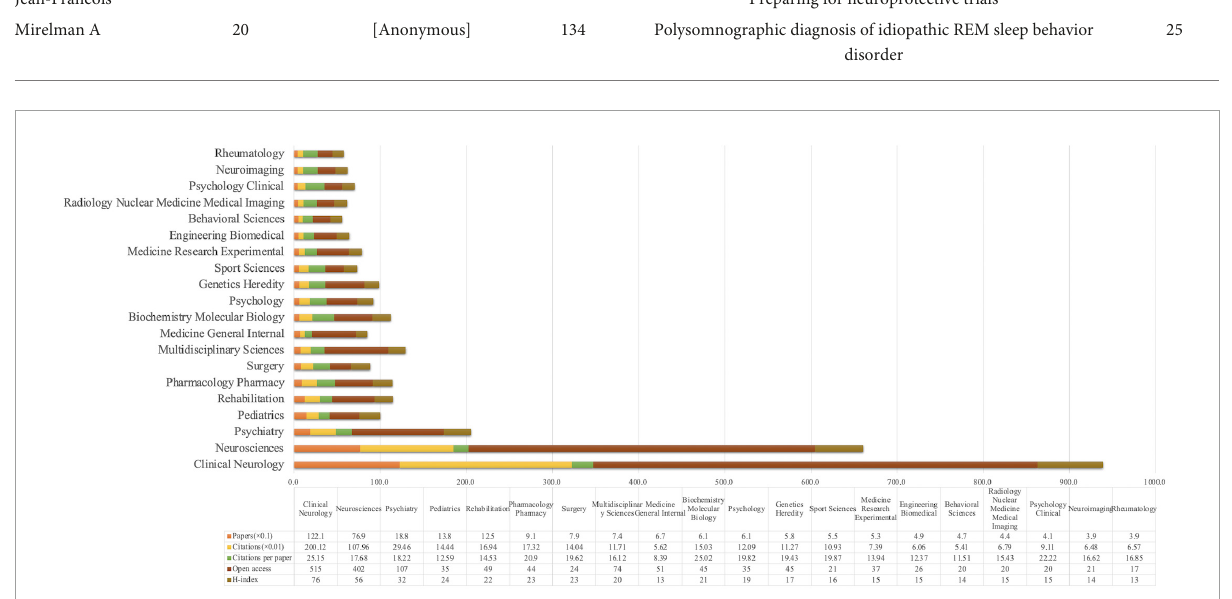
FIGURE7 Analysis of the number of publications, citations, average per item, open access, and h-index for exercise for subject categories in the field of movement disorders.